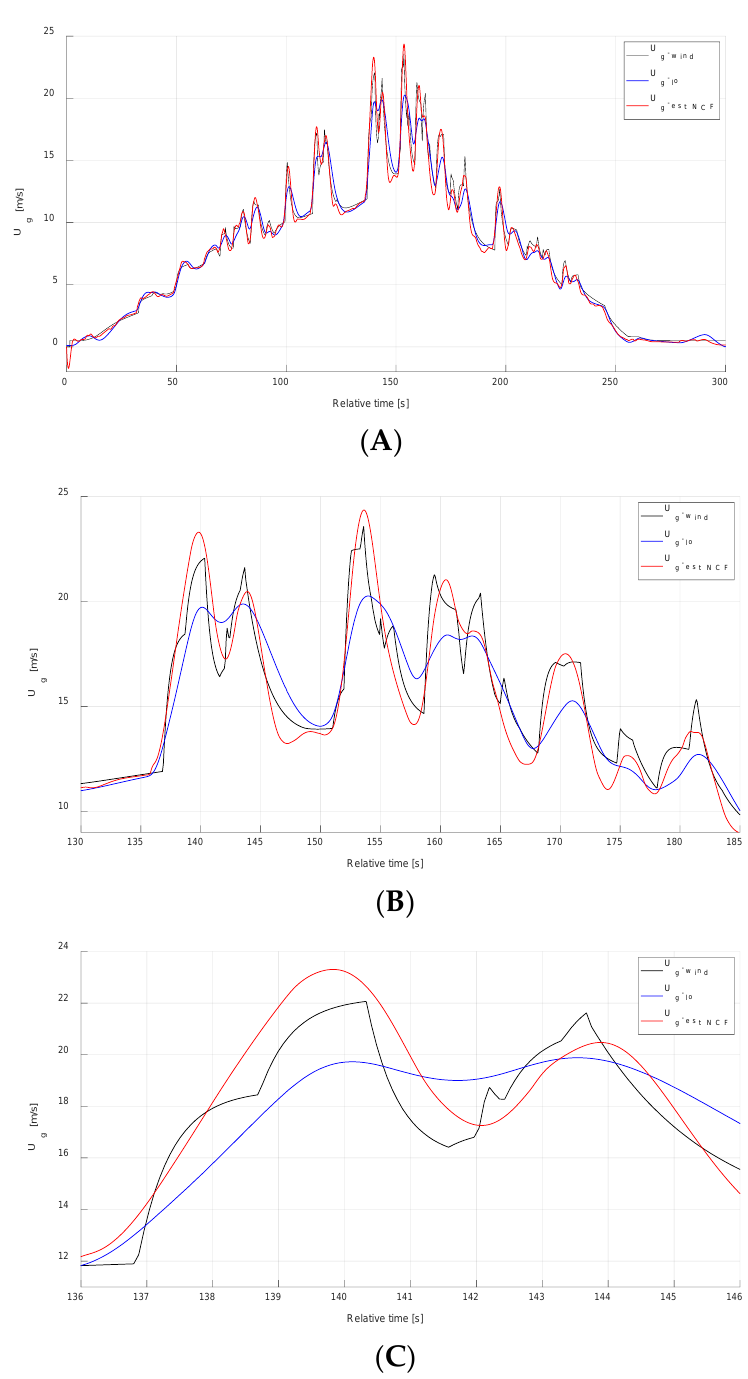
Figure 20. Comparison of the gust value with the estimation results (non-linear complementary filter, estimation delay reduced by 1.5 s)—flight crossing a gust area; ( A ) whole simulation, ( B ) several selected gusts, and ( C ) single selected gust.